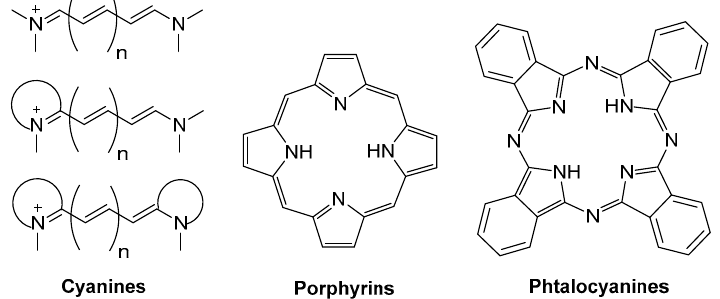
Figure 1. Molecular structures of the most commonly tested red and near-infrared (NIR) dyes based on cyanine backbones.